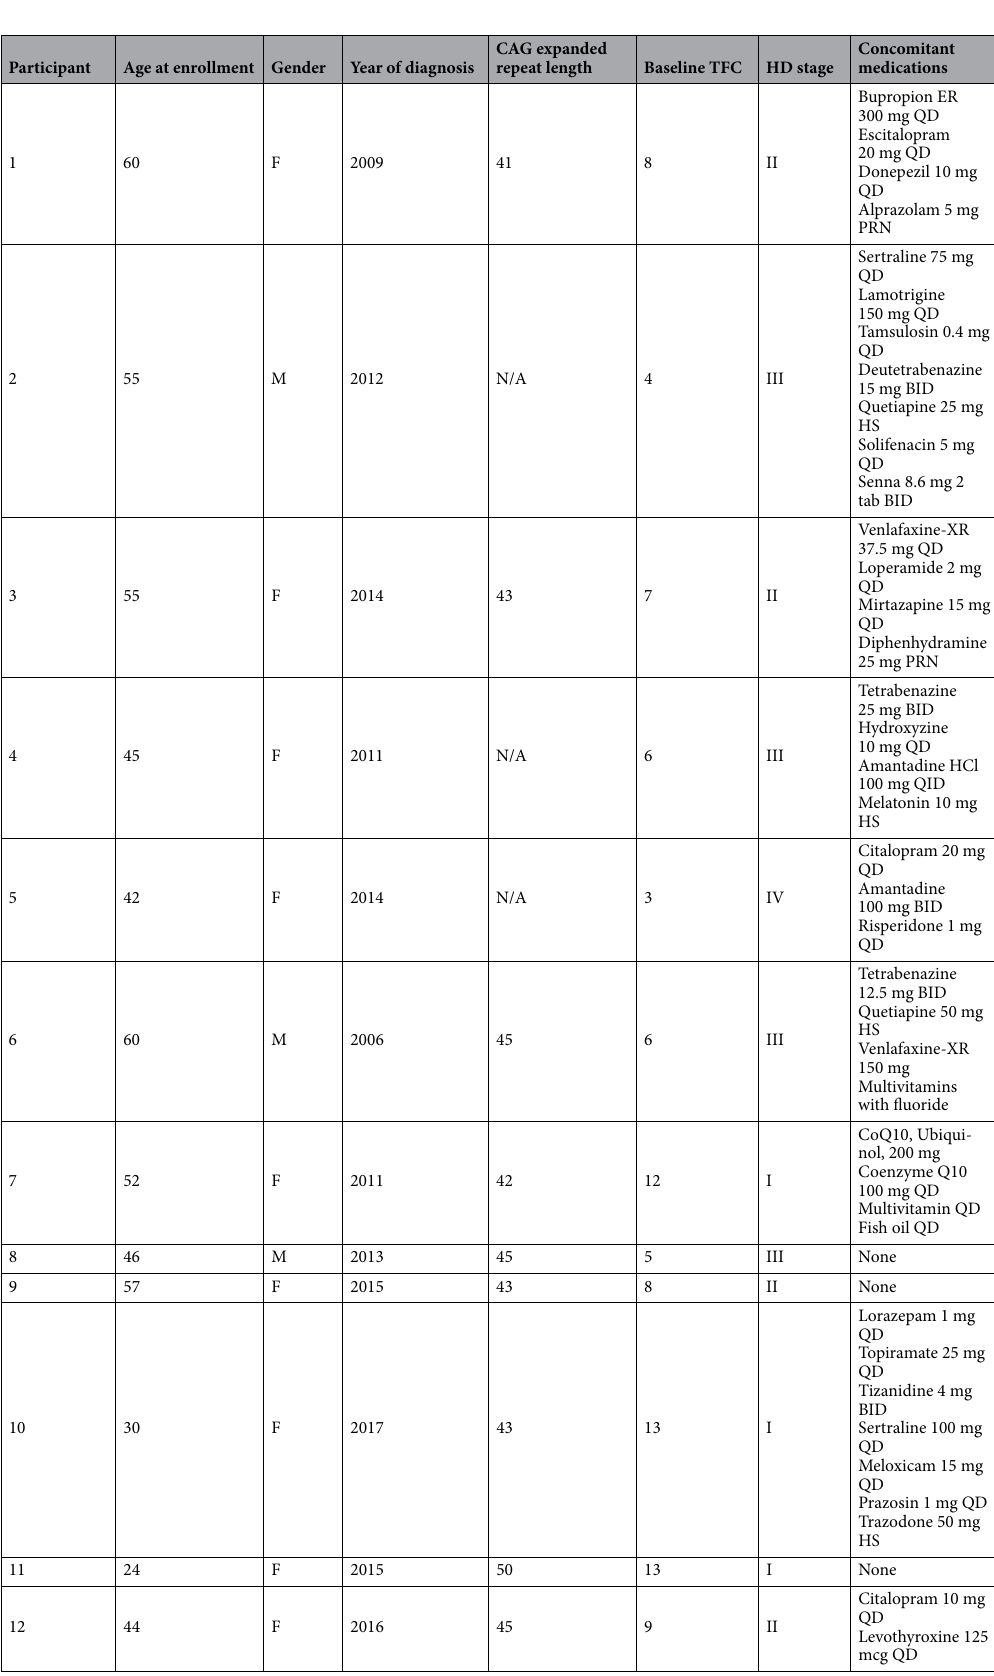
Table 1. Participant demographic data. N/A: For CAG repeat length, diagnosis was established by first-degree relative and diagnostic confidence level